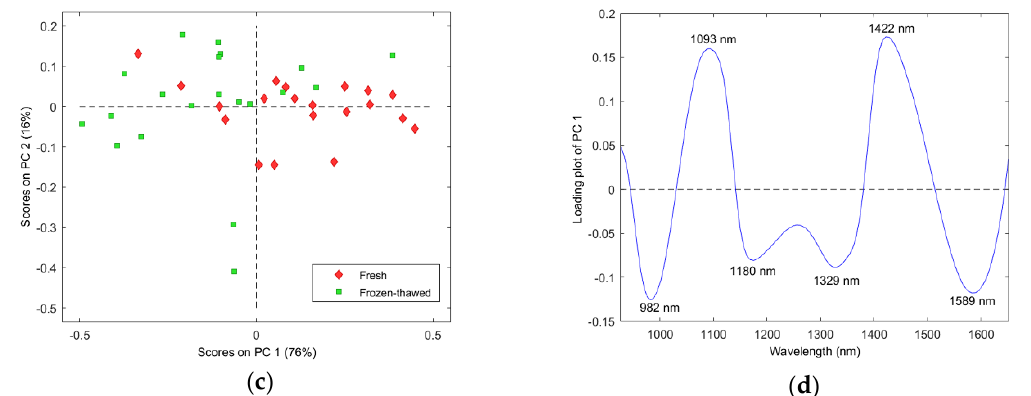
Figure 4. PCA analysis (SNV + detrend pre-processed) of ( a ) zebra, ( b ) springbok, and ( c ) ostrich (frozen up to one month), illustrating good separation between fresh ( red ) and frozen–thawed ( green ) classes. Scores illustrated as PCA score plots of PC1 vs. PC2; ( d ) PCA loading line plot for PC1 with interpretable bands at 982, 1093, 1180, 1329, 1422, and 1589 nm.